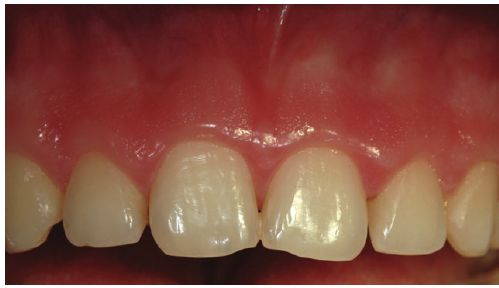
Figure 2: Pretreatment view of upper anterior